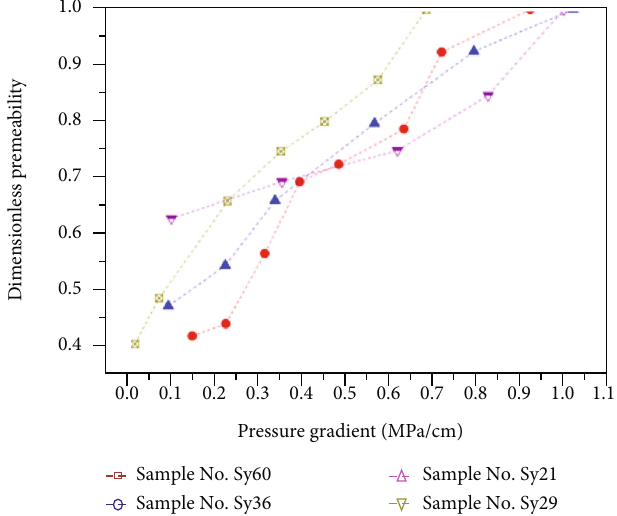
Figure 10: Plot of the dimensionless permeability vs. pressure gradient. The dimensionless permeability is the ratio of the apparent permeability to the maximum apparent permeability. Table 3: Threshold pressure gradients of the cores with di ff erent pore structures and their fi tting parameters. Pore structure Sample